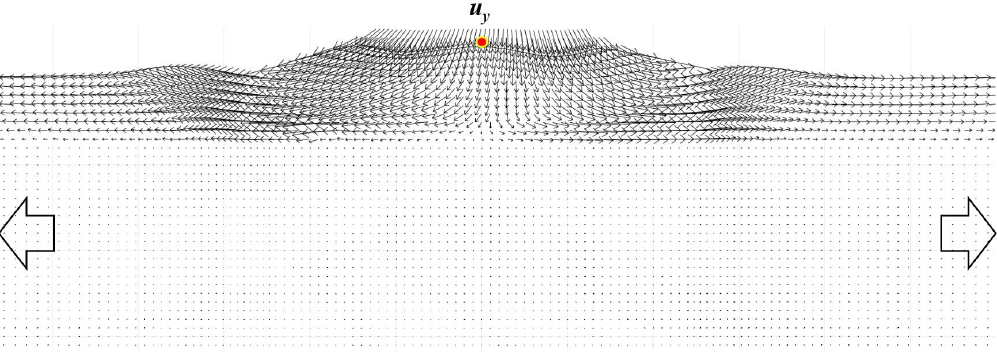
Figure 5. Example of a deformed embankment shape (u y —vertical displacement at the crest midpoint used for derivation of fragility curves).